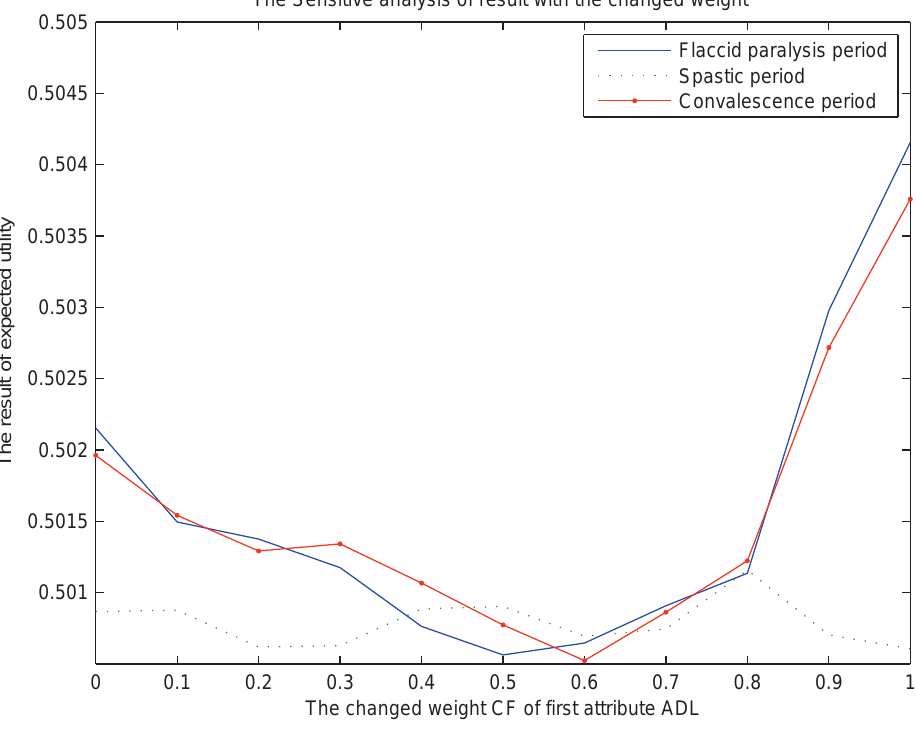
Fig. 2. The result of utilities with changed weight of first attribute-ADL.